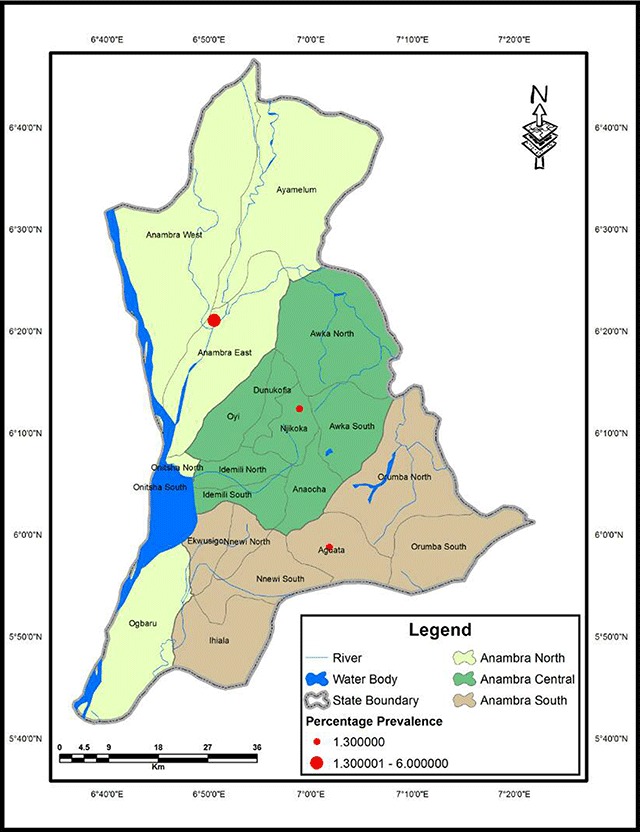
Prevalence of urinary schistosomiasisbysenatorial districts in Anambra State, Nigeria.